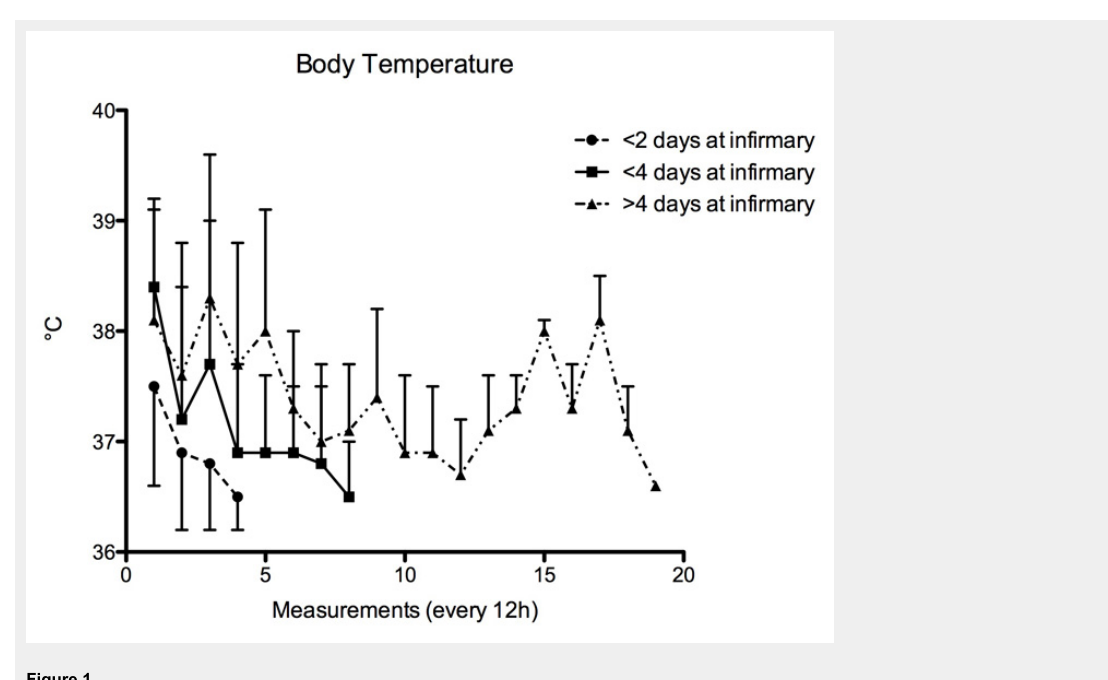
Body temperature of patients according to their length of stay at infirmary.